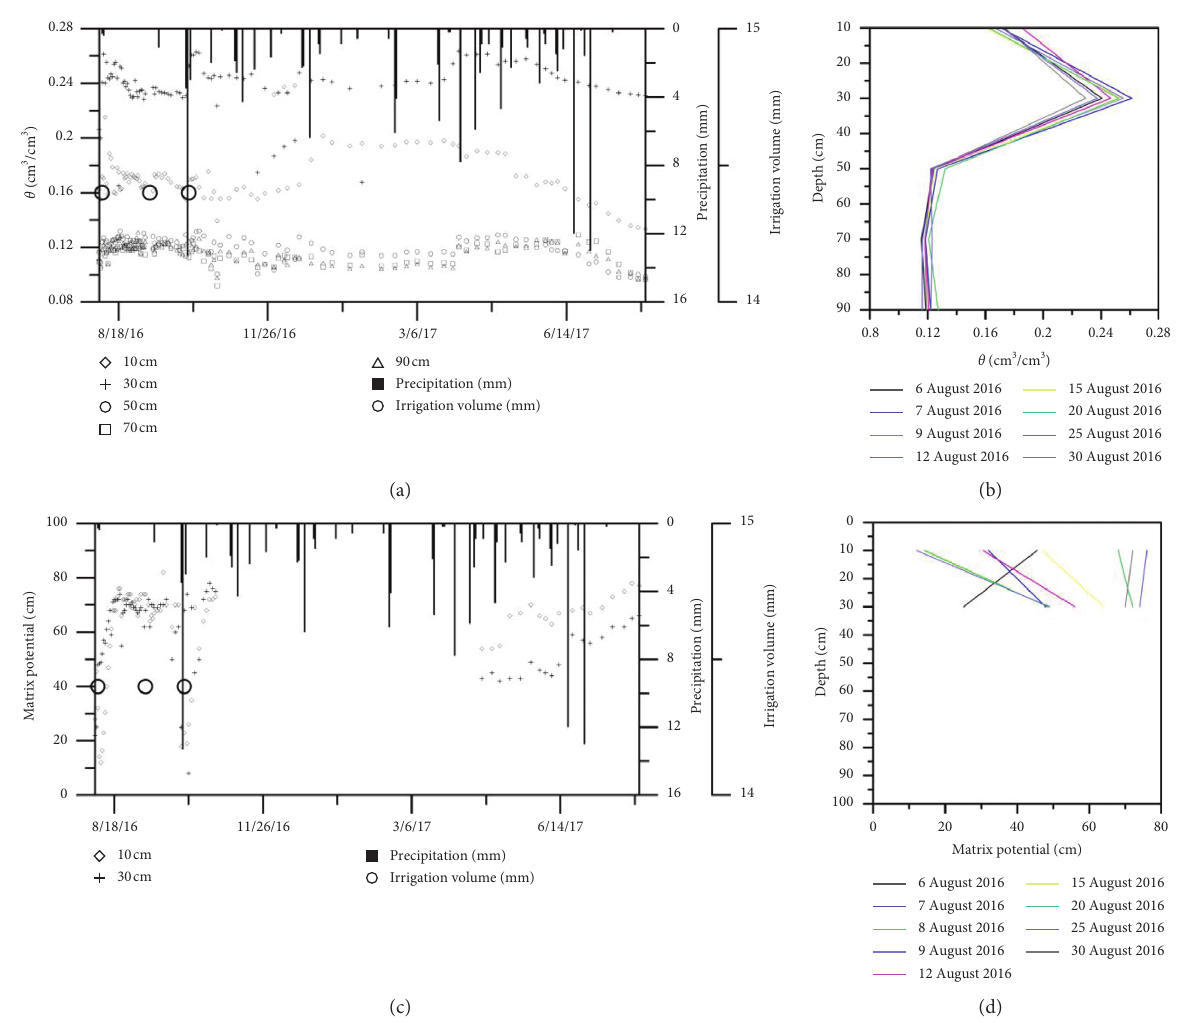
Figure 8: Water distribution in soil with a thickness of 30cm with compaction once: (a) water distribution at different depths; (b) response of water content to irrigation; (c) matrix potential at different depths; (d) response of matrix potential to